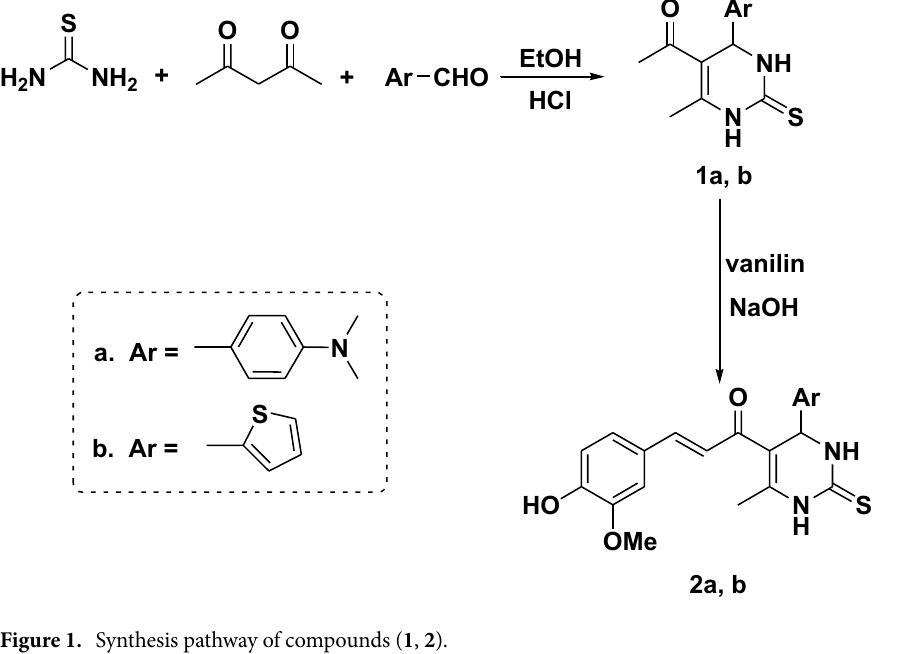
Figure 1. Synthesis pathway of compounds ( 1 , 2